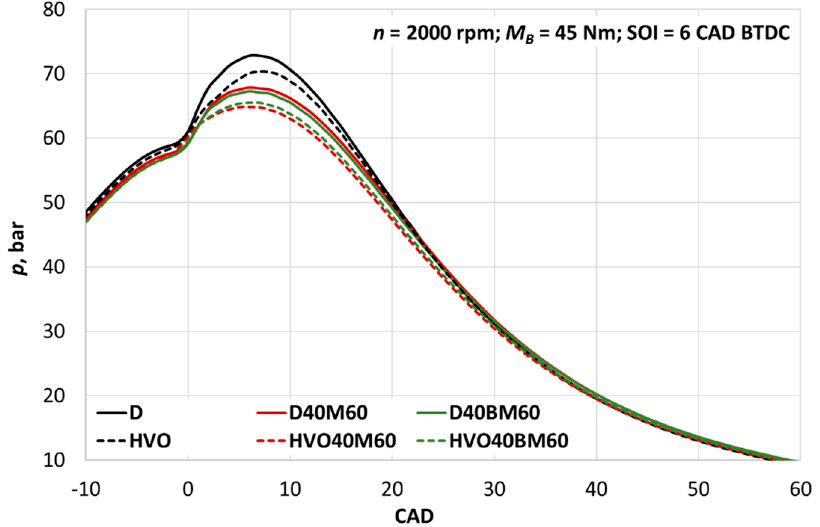
Figure 10. Pressure in the cylinder depending on fuel composition.